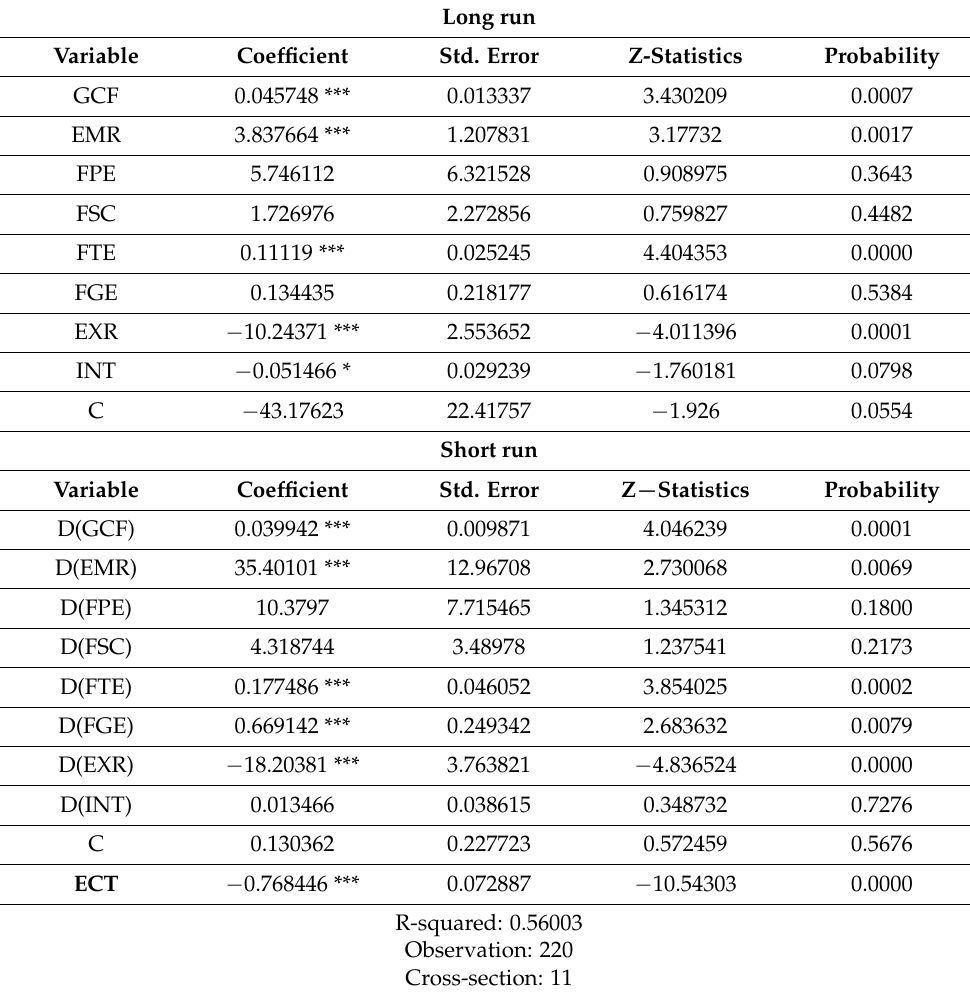
Table 5. CS-ARDL Estimation Result for the Aggregate